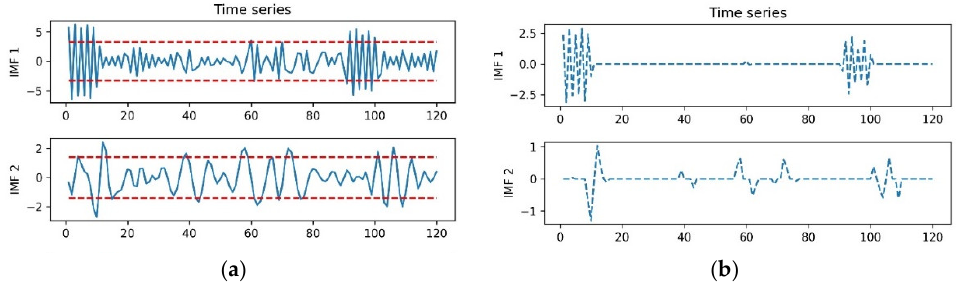
Figure 10. Soft threshold results. ( a ) The soft threshold in imf 1 and imf 2 . ( b ) Threshold-based smoothed results in imf 1 and imf 2 .